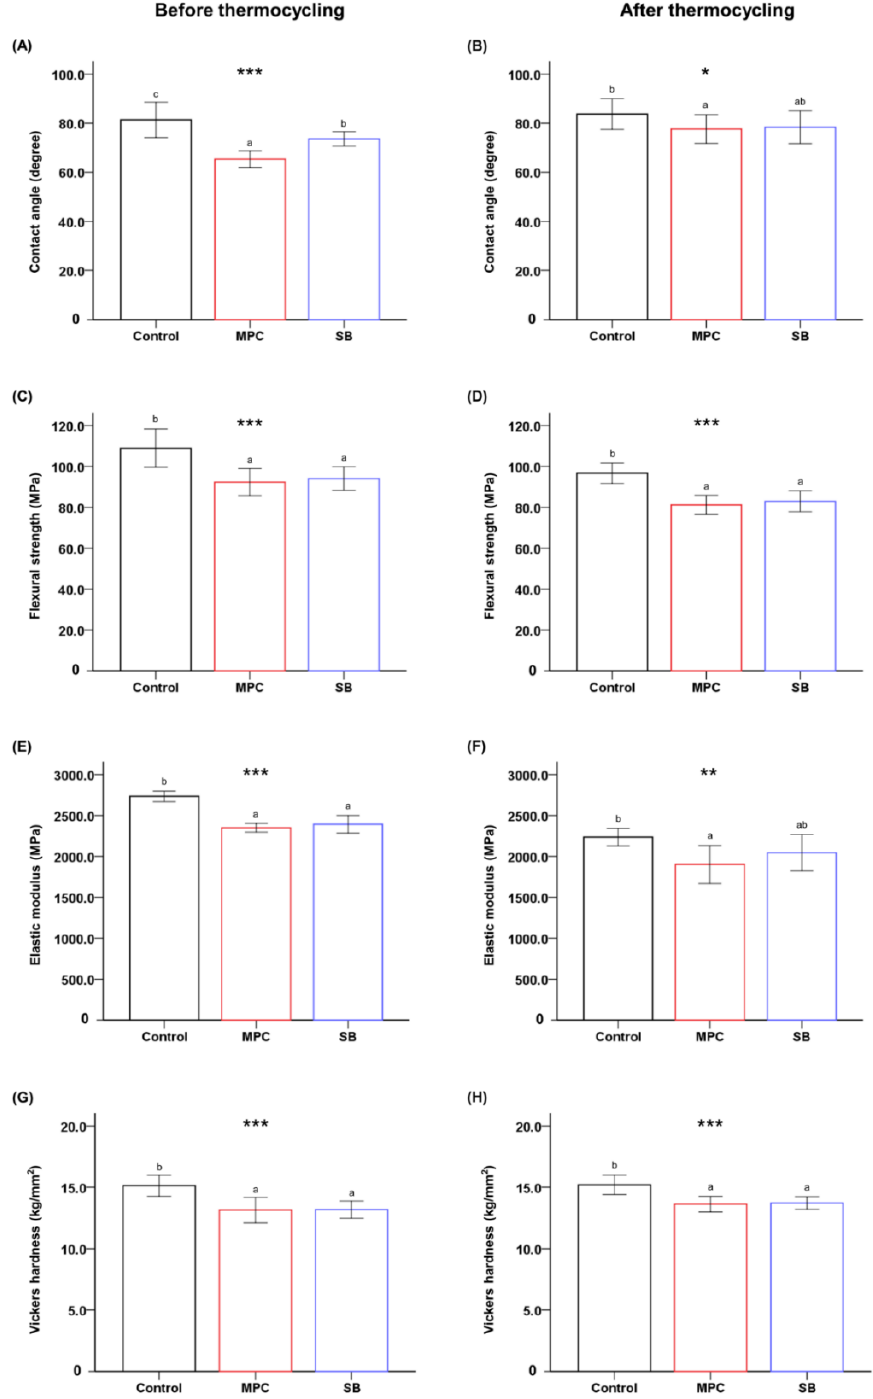
Figure 1. Physical and mechanical properties in terms of the contact angle ( A , B ), flexural strength ( C , D ), elastic modulus ( E , F ), and Vickers hardness ( G , H ) of poly(methyl methacralyate) (PMMA) before (Control) and after the addition of 3 wt% 2-methacryloyloxyethyl phosphorylcholine (MPC) or sulfobetaine methacrylate (SB). Results obtained before (left) and after thermocycling (right) are shown. Different lowercase letters above the bars indicate significant differences by post-hoc Tukey’s test. *** p < 0.001, ** p < 0.01, * p < 0.05 for comparisons between PMMA with and without the zwitterion analyzed by one-way analysis of variance